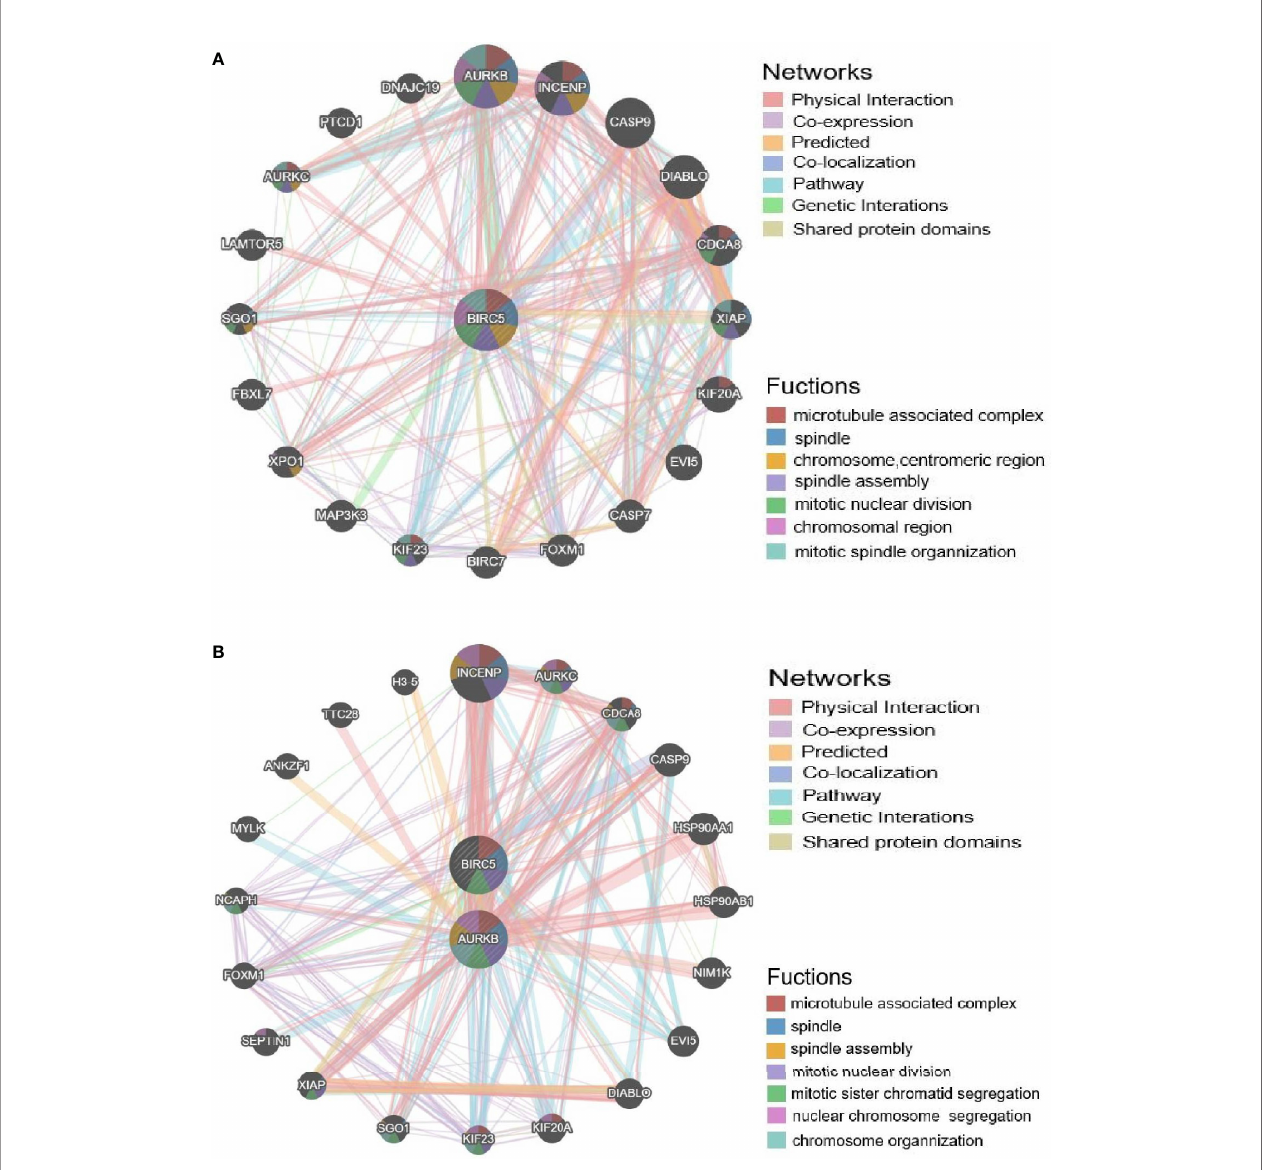
FIGURE 10 | Validation of the afatinib resistance function of BIRC5. (A) PPI network of BIRC5 produced by GeneMANIA. (B) PPI network of BIRC5 and